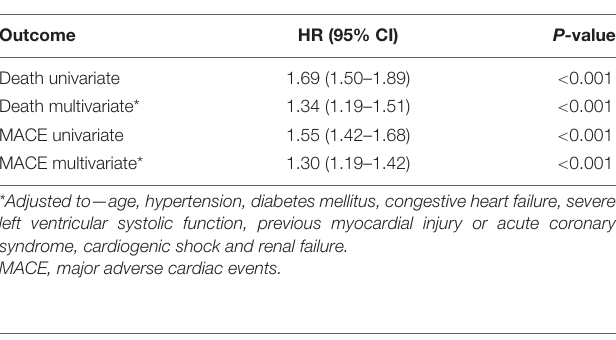
TABLE 5 | Cox regressions models—complex vs. non-complex